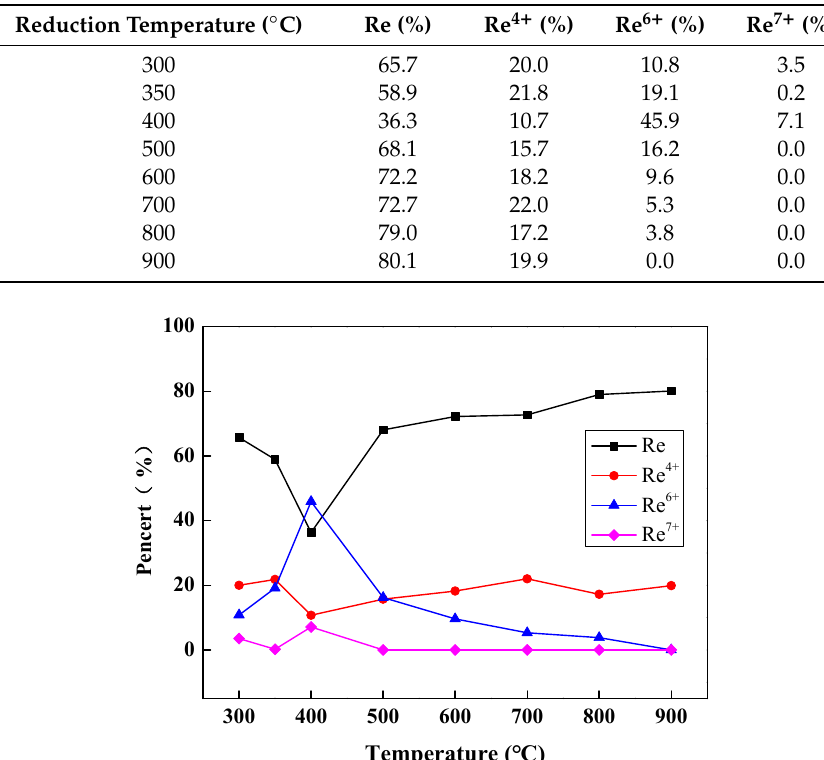
Table 4. The percents of rhenium atom in each valence state of the reduction products of ammonium perrhenate (D 50 was 81.05 µm, specific surface was 21.72 m 2 /kg) at different temperatures.